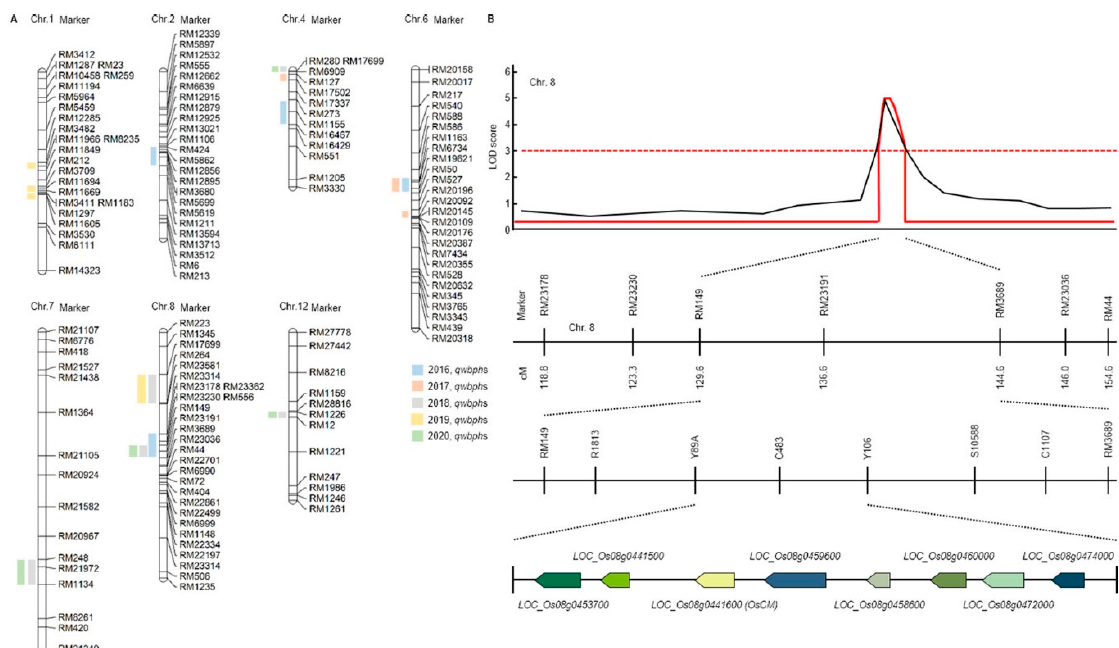
Figure 1. Quantitative trait loci (QTL) analysis and physical mapping related to white backed planthopper (WBPH). ( A ) RM23191 on chromosome 8 was commonly detected in 2016, 2018 and 2020. Eight candidate genes were detected for the WBPH resistance. ( B ) QTL analysis and physical mapping related to WBPH. When QTL mapping analyzed, the RM149-RM3689 region was detected with an LOD score of 3.0 or higher. When closed mapping is performed around this region, eight candidate genes ( Os08g0453700 , Os08g0441500 , Os08g0441600 , Os08g0459600 , Os08g0458600 , Os08g0460000 , Os08g0472000 , Os08g0474000 ) for the WBPH resistance were detected.